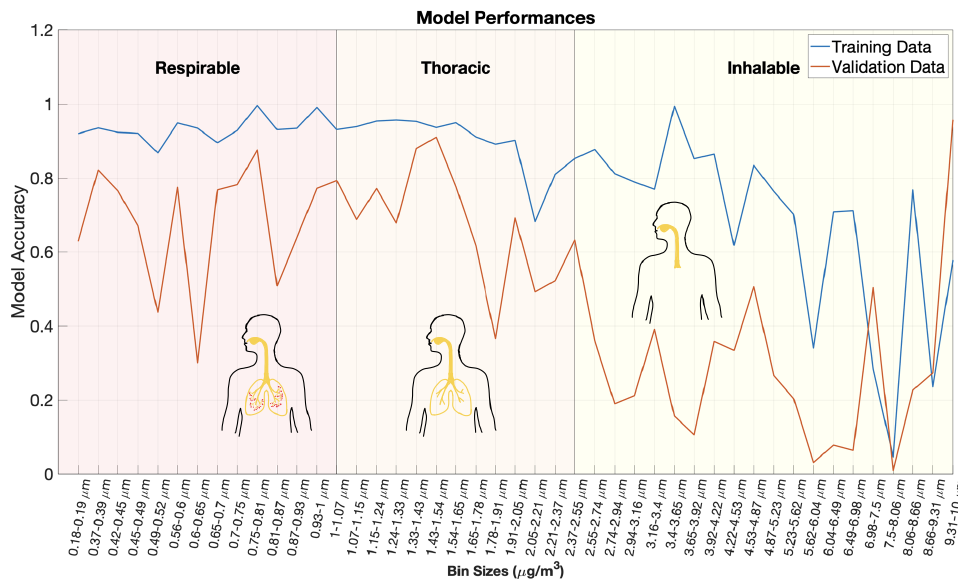
Figure 10. Model accuracies plotted against bin size. Forty-five separate PM models were trained for size bins ranging from 0.18 to 10 micrometers. PM values were estimated solely from 9 non-EEG biometric variables. Training dataset performance is plotted as a blue line and validation dataset performance is plotted in orange. A clear drop in model performance is observed between 2–3 micrometers. Overlaid graphics indicate the deposition of the respective PM size bins in the airways